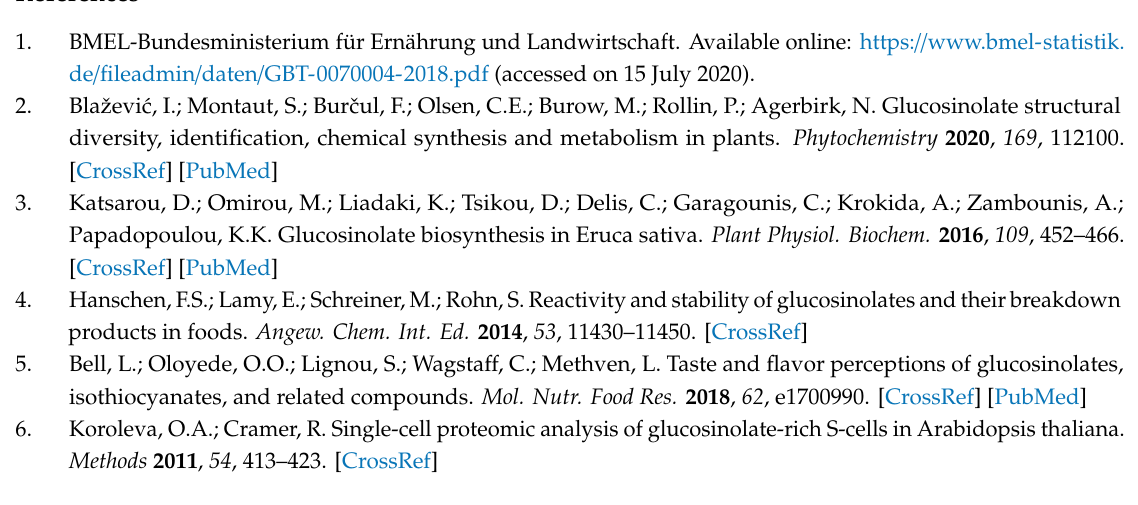
s1, Figure S1: Allyl glucosinolate hydrolysis product ratios [percentage of allyl isothiocyanate (Allyl-ITC), 3-butenenitrile (Allyl-CN) and 1-cyano-2,3-epithiopropane (CETP)] from white (A–C) and red cabbages (D–F) from conventional (A, B, D, E) and organic supermarkets (C, F) on di ff erent sampling dates (S1–S6). Table S1: Overview of white and red cabbages purchased from three di ff erent food retailers or harvested freshly from the field (Großbeeren, D). Table S2: Glucosinolates (GLSs) content in commercial and cabbages harvested freshly from the field in µ mol / g fresh weight. Table S3: Glucosinolate (GLS) hydrolysis product formation in commercial and cabbages harvested freshly from the field in µ mol / g fresh weight. Table S4: Climatic data of the Dithmarschen region in northern Germany in